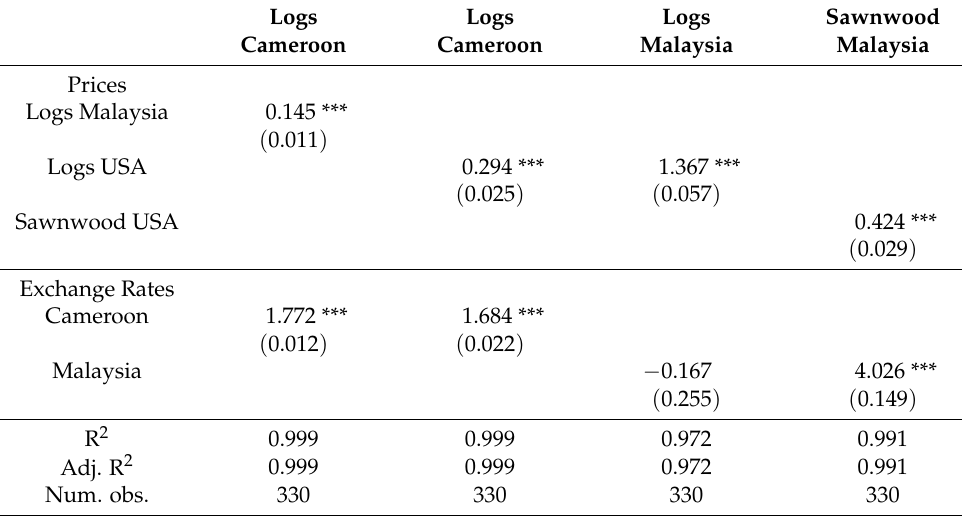
Table 1. Exchange rate pass-through coefficient estimates. Logs Logs